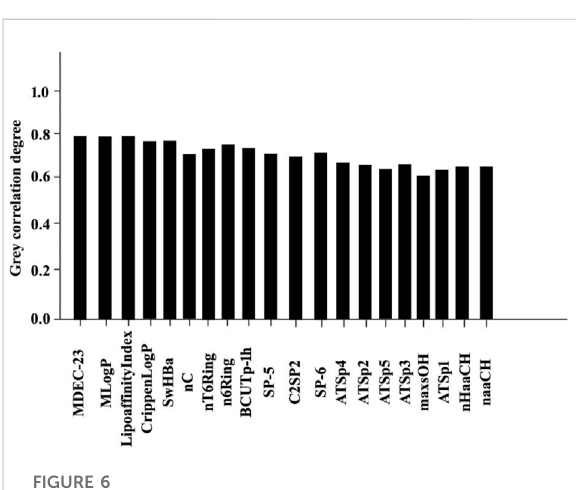
FIGURE 6 Statistical results of 20 bioactive molecules based on Grey correlation analysis.